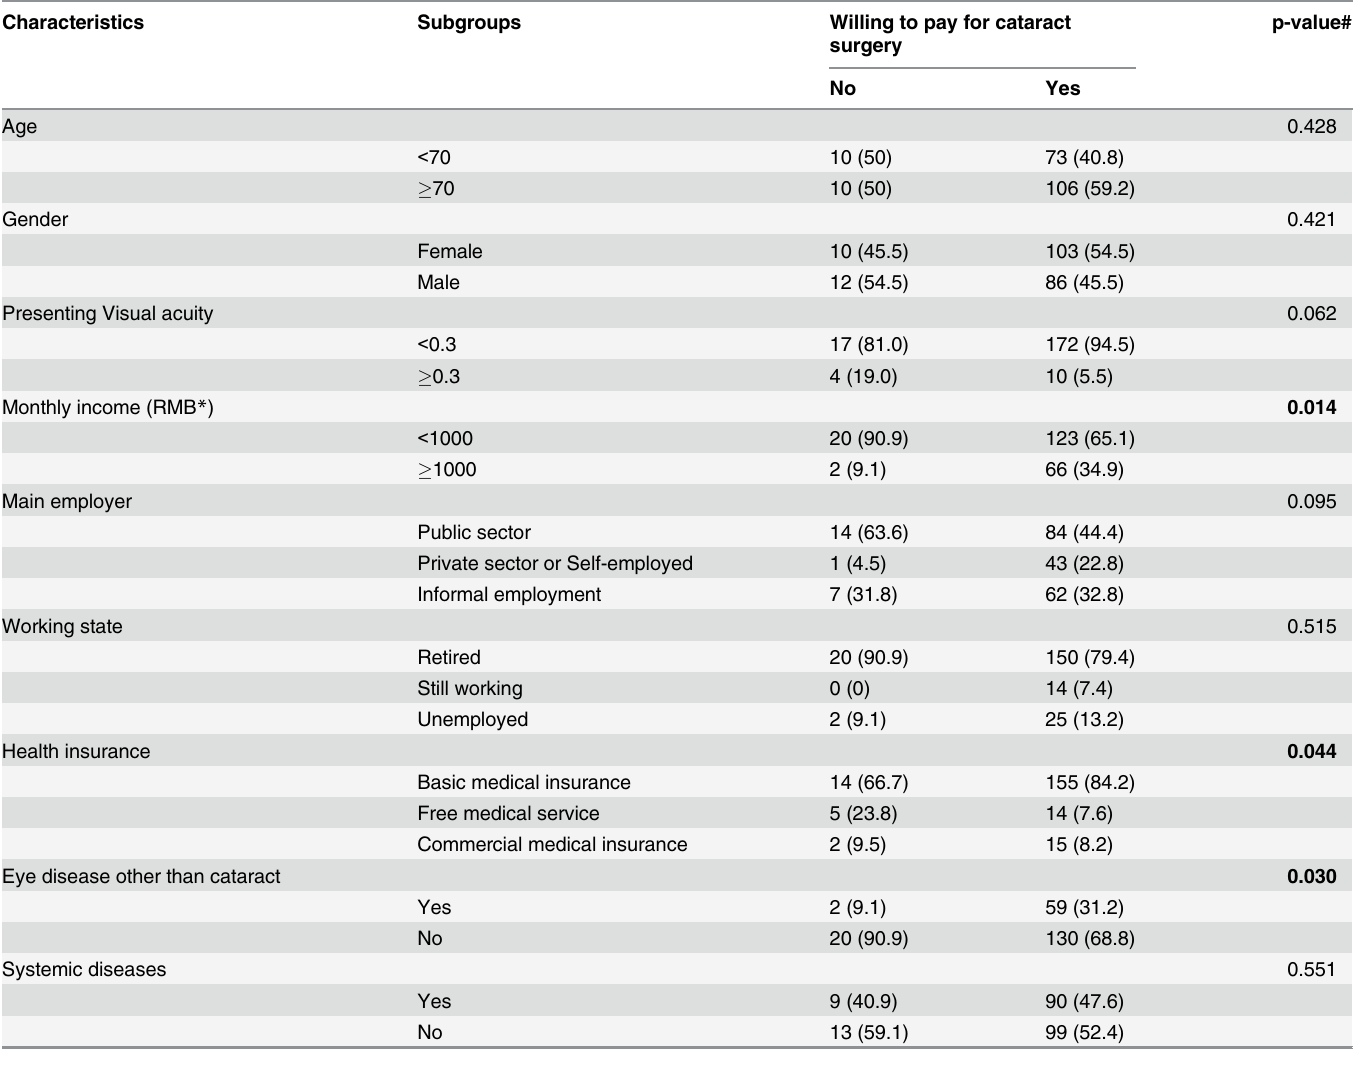
Table 1. Analysis of willing to pay for cataract surgery, Guangzhou,